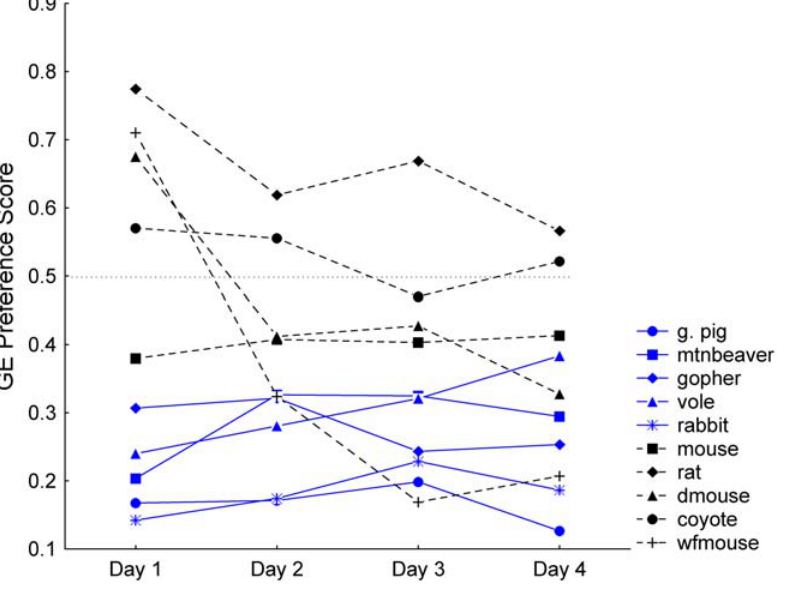
Figure 5. Daily GE preference scores. Species means for each day of testing. Blue symbols (solid lines) are herbivores; black symbols (dashed lines) are omnivores.